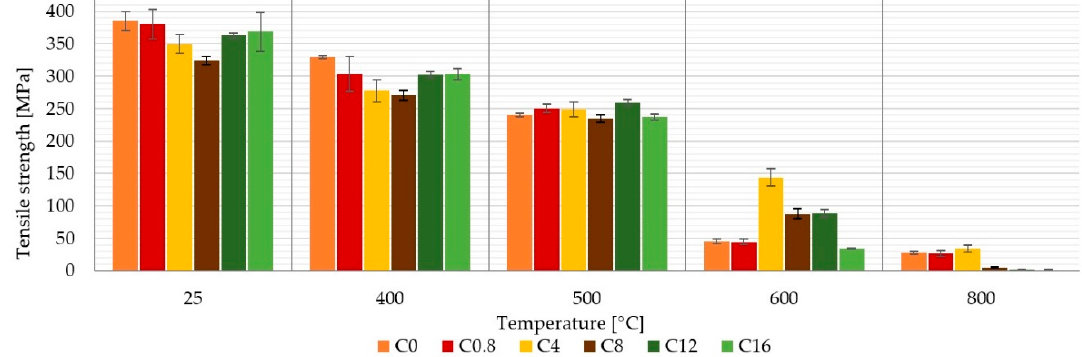
Figure 5. Influence of temperature and boron content in the matrix on the tensile strength of composites. Samples without high temperature treatment had tensile strength from 385 to 324